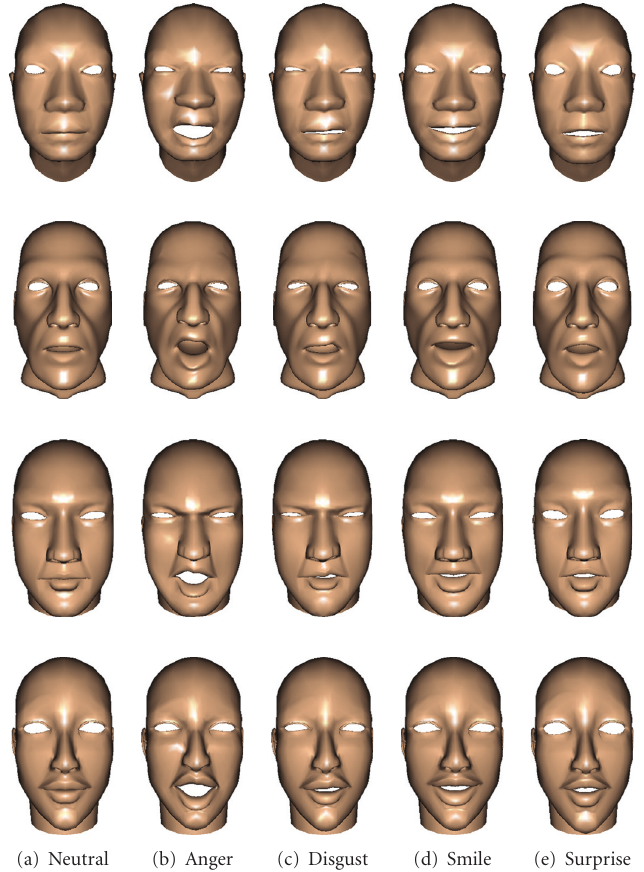
Figure 6: First row shows the source models and the other rows show target models generated by expression cloning. The expressions are retrieved from the source model and are copied on each target model. Left most column shows the neutral expression of each